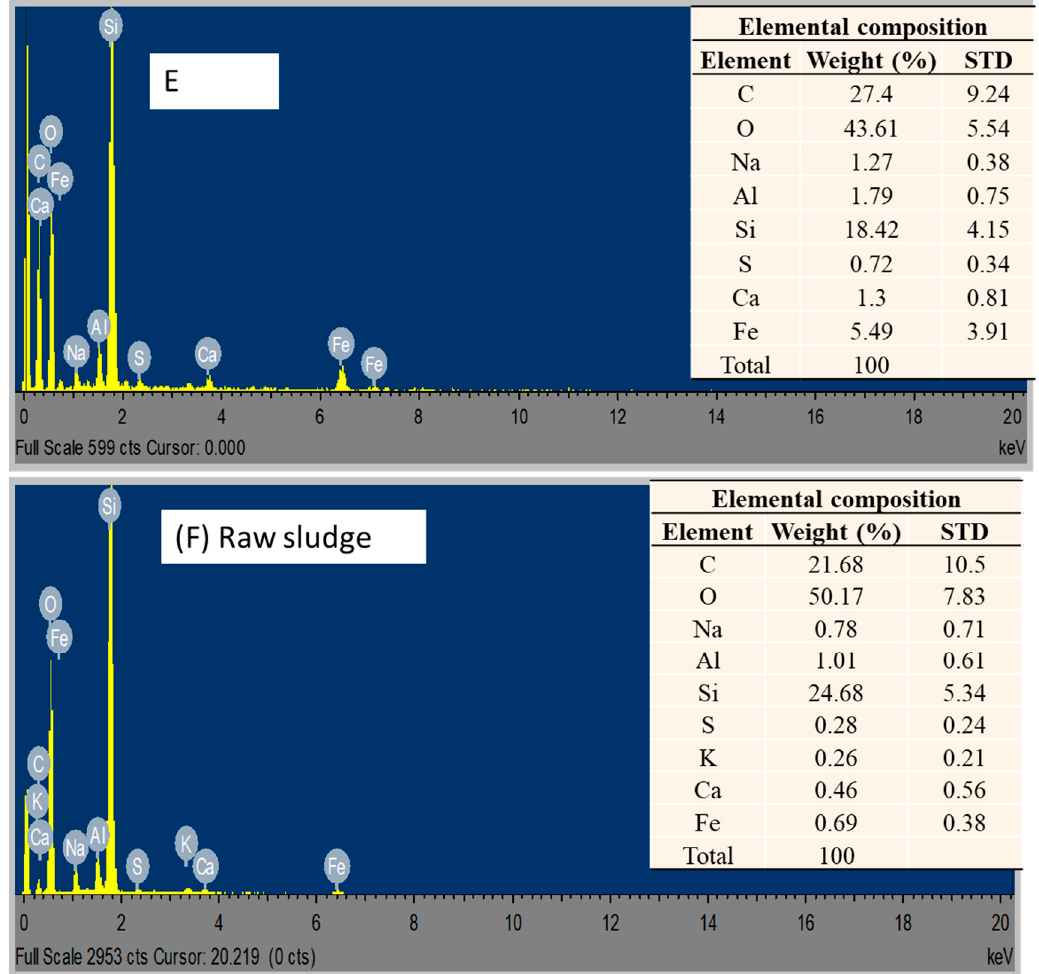
Figure 2. EDX images for post-digestate of bioreactors A–D charged with 2 g of ( A ) Fe 2 O 4 -TiO 2 ; ( B ) Cu-Fe 2 O 4 ; ( C ) Fe 3 O 4 ; and ( D ) Chitosan-Fe 2 O 4 /TiO 2 MNPs, whereas bioreactor E is a control: ( E ) no MNPs and ( F ) raw sludge .